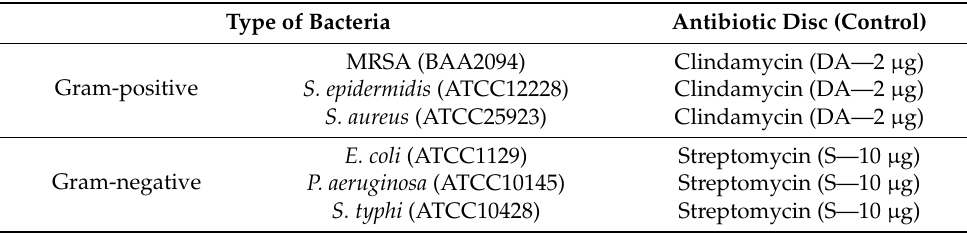
Table 1. List of strains and their control antibiotic discs. Type of